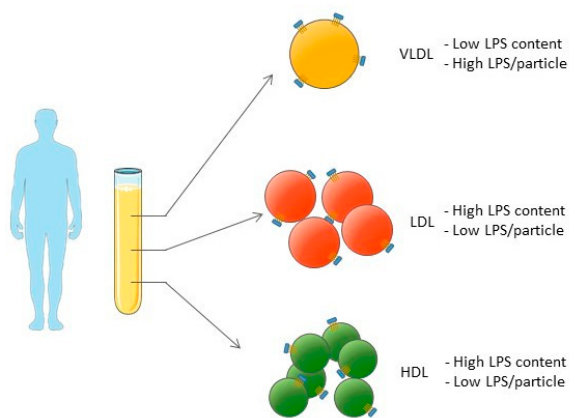
Figure 3. Summarized distribution of LPS among lipoproteins.